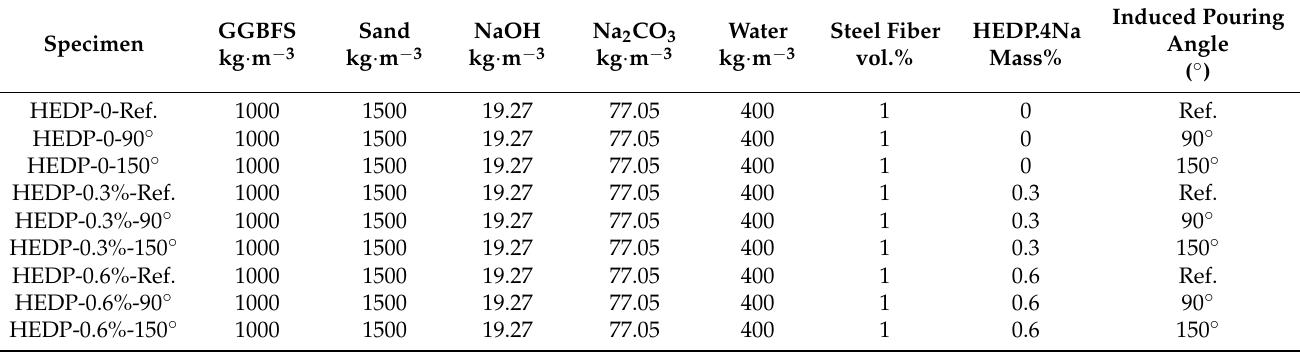
Table 2. Mixture proportions of